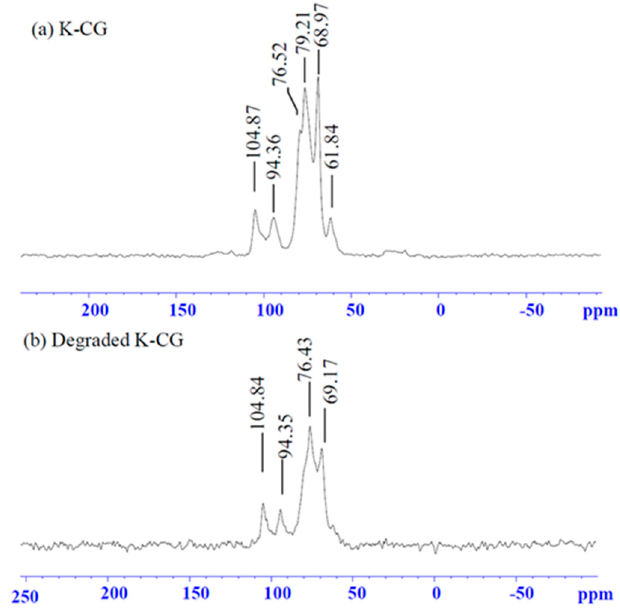
Figure 2. 13 CNMR analysis of K_CG and degraded K_CG.